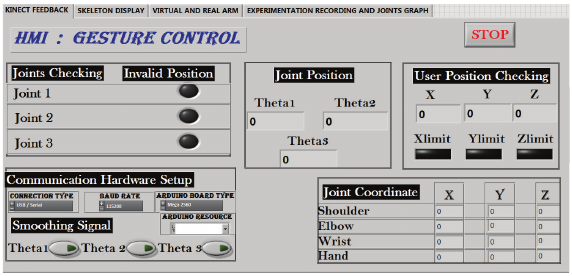
Figure 8: Fourth screen of the user